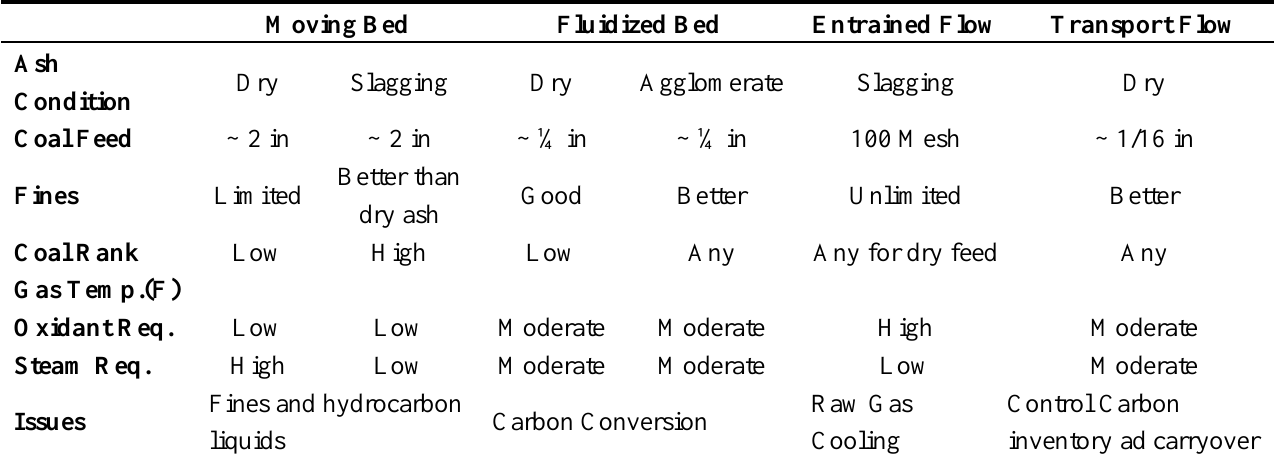
Table 3 Gasifier Configuration